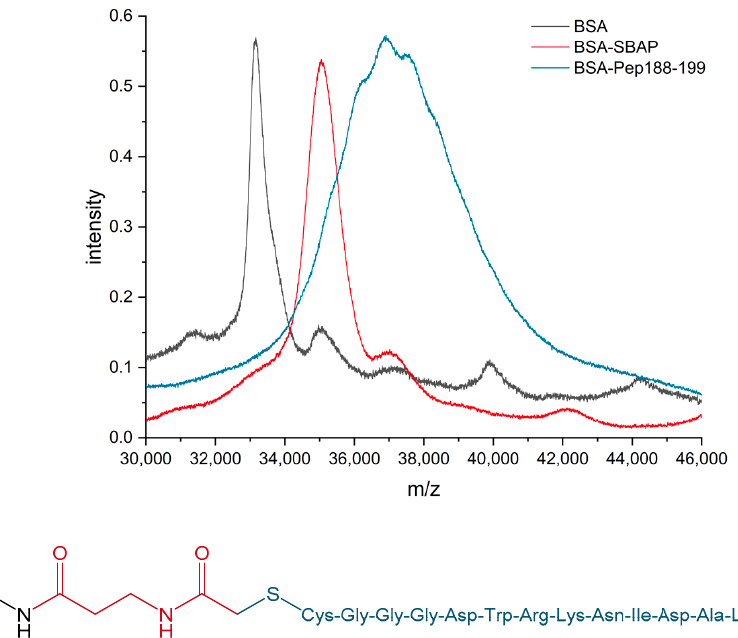
Figure 5. MALDI-TOF-MS of doubly charged species [M+H] 2+ of BSA (black), BSA-SBAP (red), and final Pep188-199-SBAP-BSA conjugate (blue). For the coupling density of the final BSA–peptide conjugate, the spectrum was fitted non-linearly with a Lorentz-fit and Levenberg Marquardt iteration algorithm (fit not shown), and the peak maximum was used for the calculation. Below, a schematic structure of the conjugate is shown. The C-terminus of the peptide is amidated. Due to the shift in the spectrum towards the higher mass range, an average of about five peptides per BSA could be calculated.